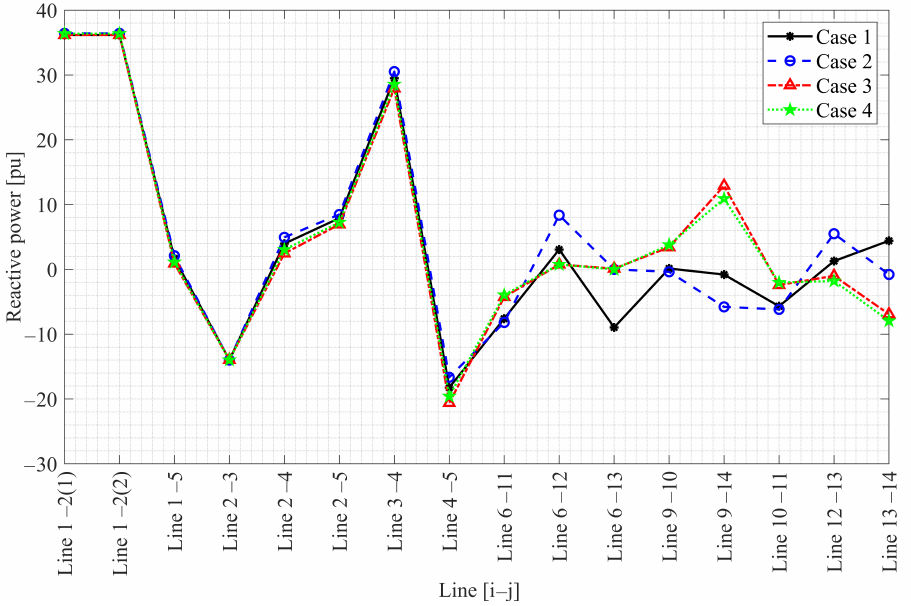
Figure 10. Reactive power flow in the 14-bus bar IEEE system.